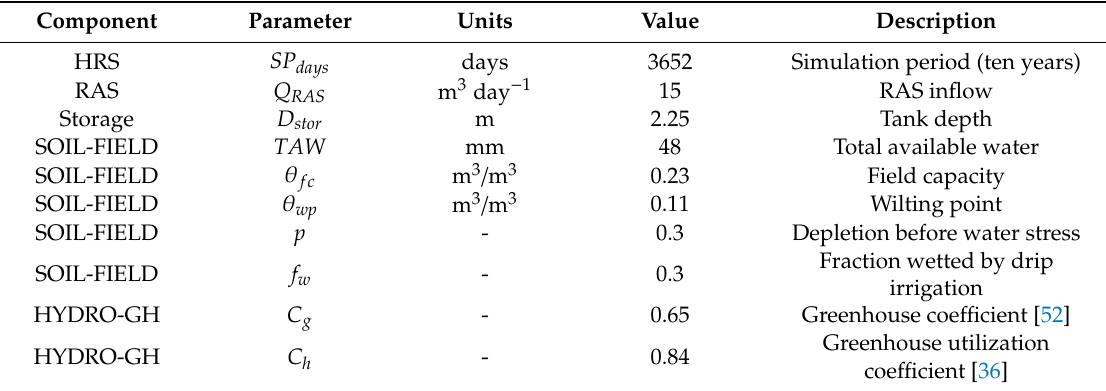
Table A2. Water balance model constants.